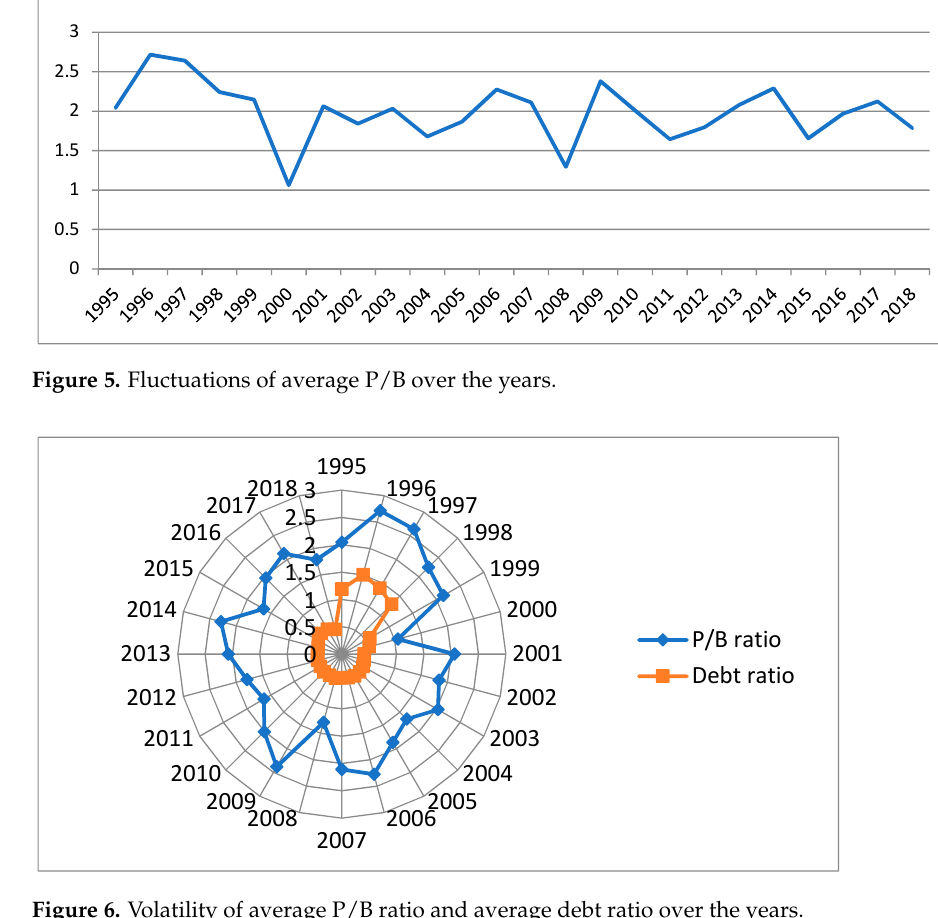
Figure 5. Fluctuations of average P/B over the years .